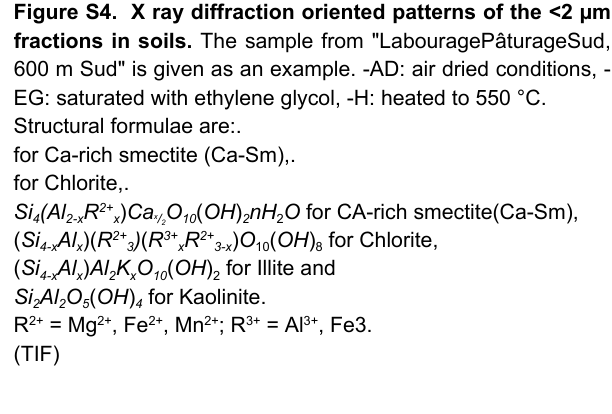
(response table = ad12.txt and table of predictors = Environnt.txt.).